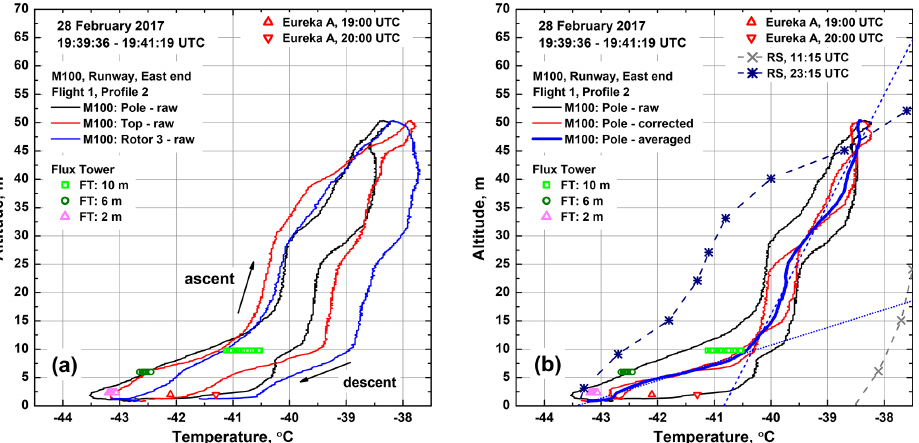
Figure 5. An example of raw (a) and time-lag-corrected (b) temperature profiles measured by M100 near the take-off and landing pad 250m south of the FT between 19:39 and 19:41UTC on 28 February 2017. In panel (b) the blue dotted line represents a 32 ◦ C ( 100m ) − 1 (320 ◦ Ckm − 1 ) inversion lapse rate, and the blue dashed line represents a 5 ◦ C ( 100m ) − 1 (50 ◦ Ckm − 1 ) inversion lapse rate (see details in